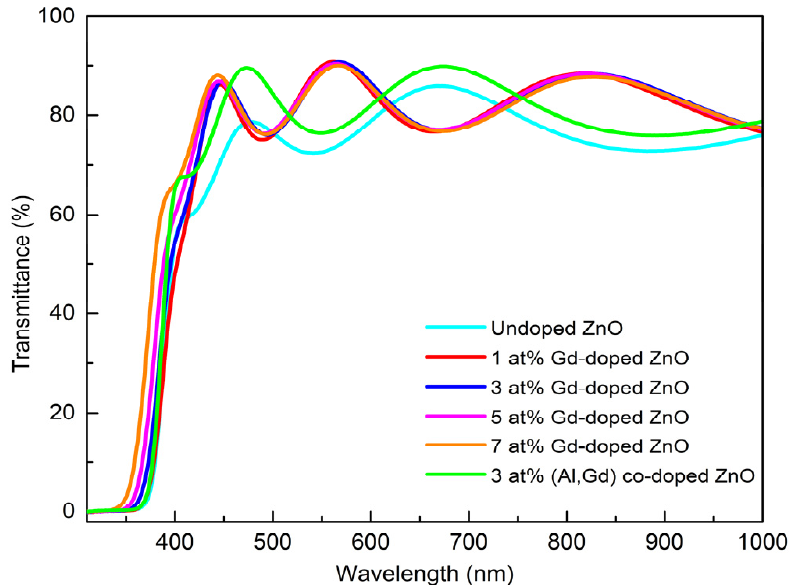
Figure 4. The transmittance of undoped ZnO, Gd-doped ZnO films with various Gd concentrations, and 3 at% (Al, Gd) co-doped ZnO films.